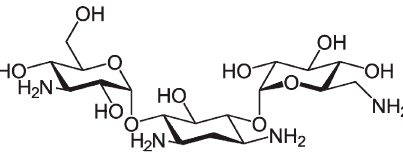
Figure 1. Structural formula of Kanamycin A (KANA).